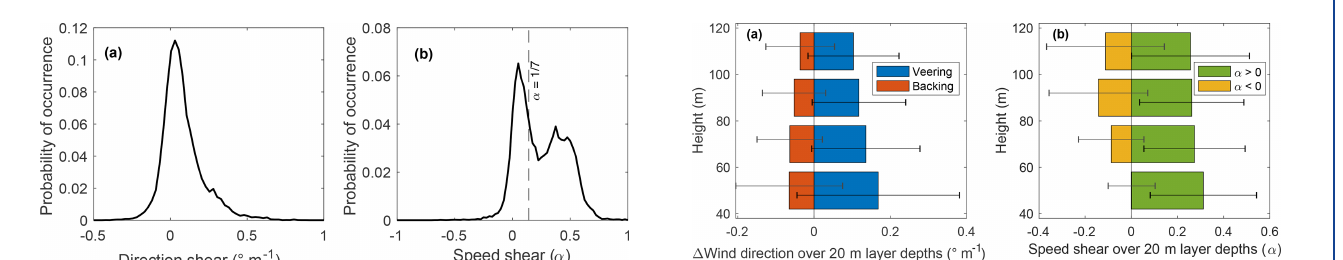
Figure 7. Probability distribution for direction shear (a) and speed shear (b) in the rotor layer (40–120ma.g.l. – above ground level).